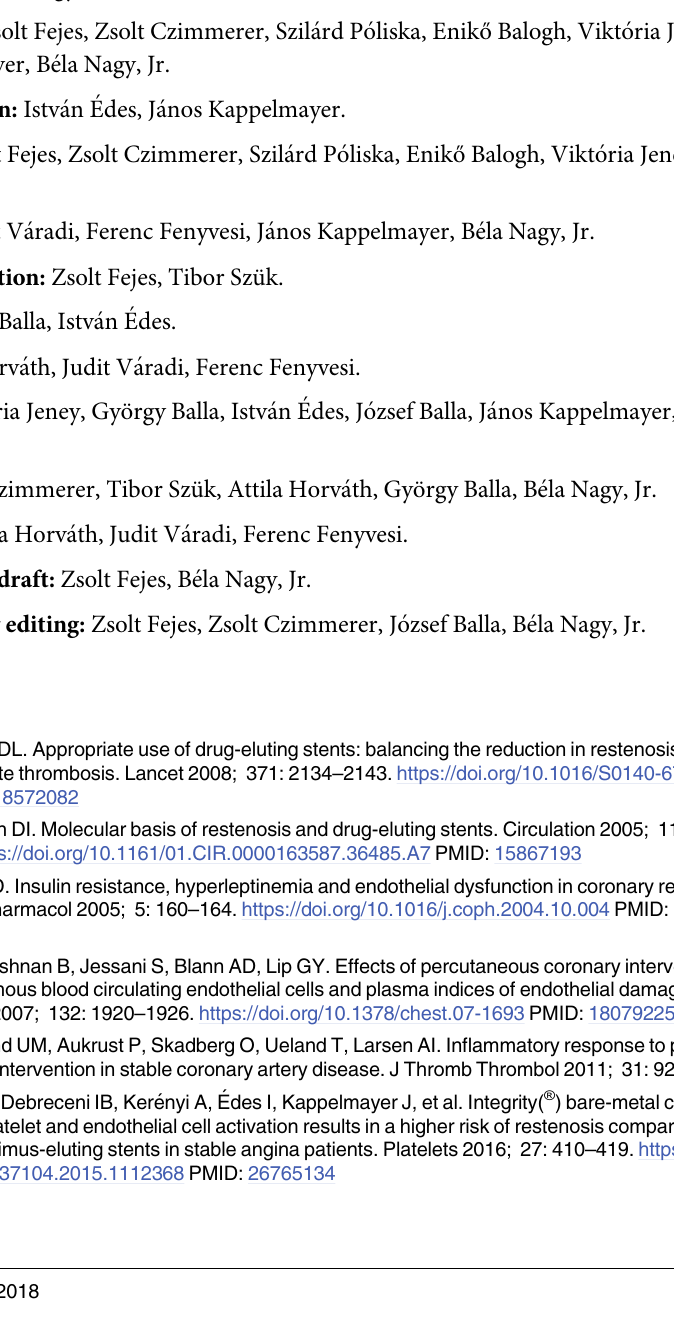
S6 Fig. Analysis of plasma miR-34a and miR-126 expression in the presence or absence of ISR in BMS and DES patients. After total RNA isolation, the expression of circulating miR- NAs was quantified in plasma samples by UPL-probe based stem-loop RT-qPCR assay. These miRNAs were significantly lower in those with ISR compared to BMS and DES subjects with- out such complication. Mean ± SEM. (All DES: n = 21, all BMS: n = 28, ISR: n =